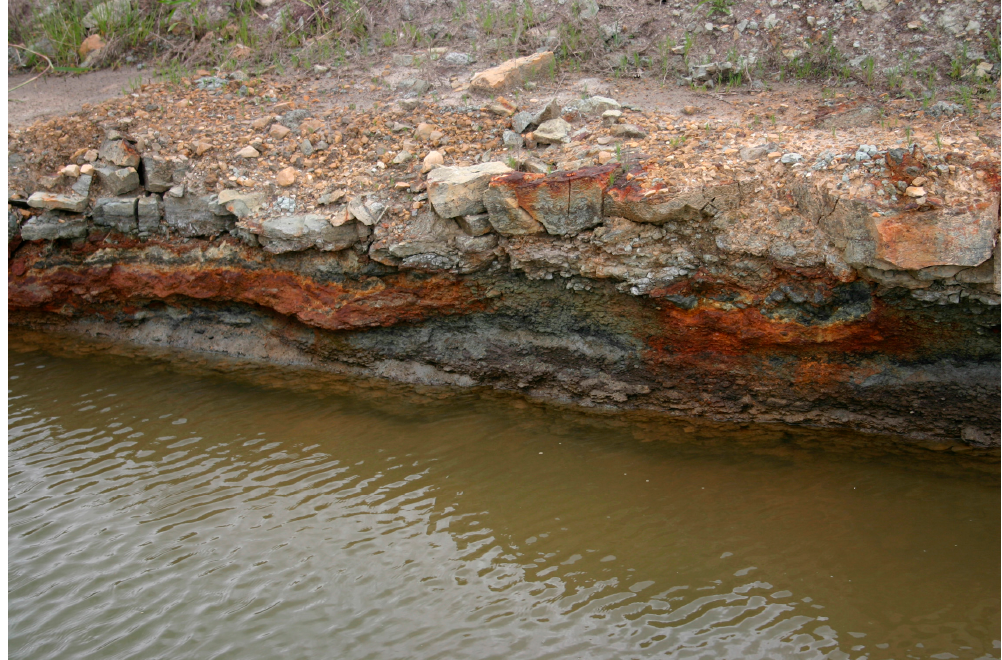
Figure 6. View of an approximately 70 cm tall section present in a bedrock sump trench at the Scott Construction Ulmen Quarry in central Brown County, Wisconsin (Location 13). Sulfides occur at the contact between the Silurian Mayville Formation (top 30 cm) and the Ordovician Neda-Maquoketa formations (lower 40 cm) and are responsible for the Fe-oxide staining.